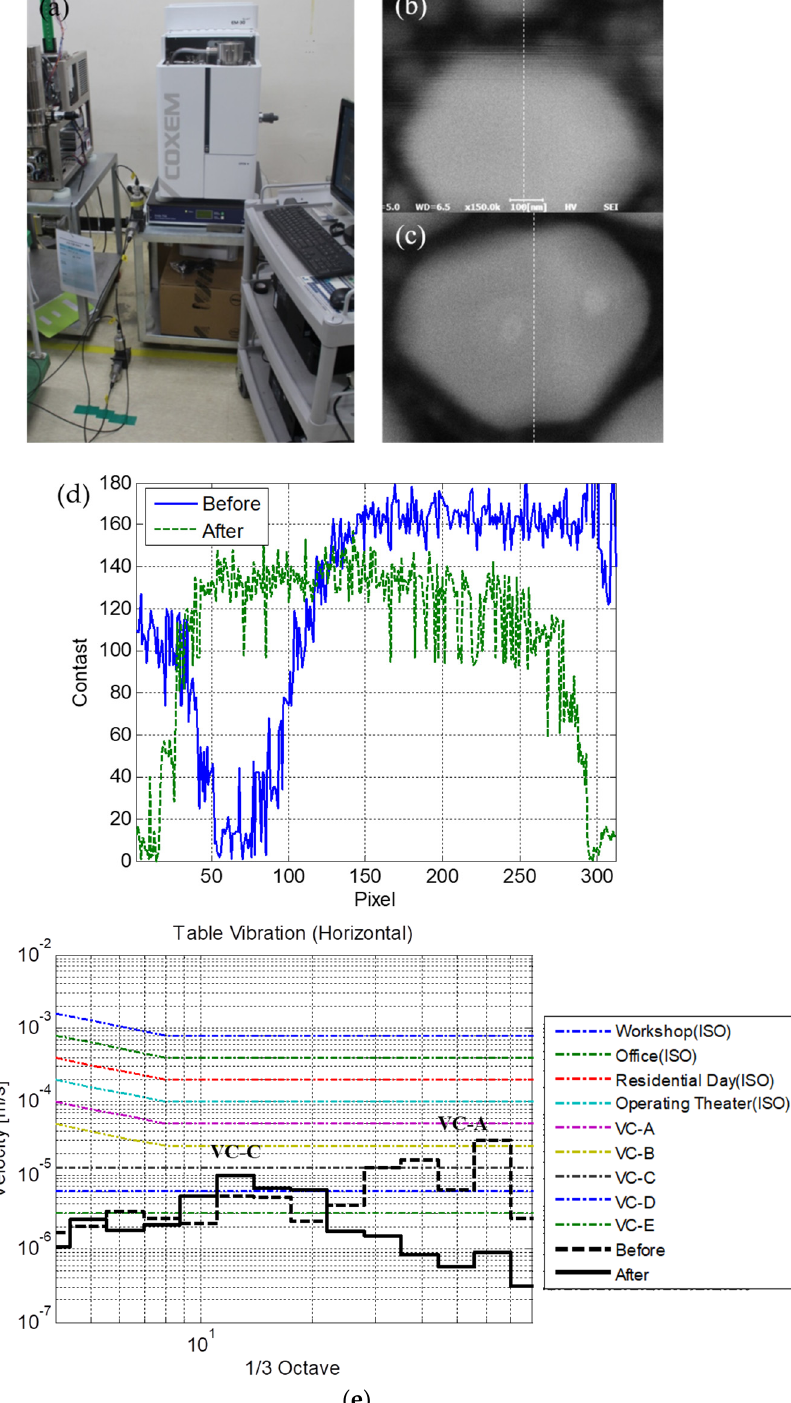
Figure 7. ( a ) Modified configuration of the overall system; measurement results for a specimen obtained using ( b ) wood and ( c ) steel table; ( d ) contrast variations in the specimen pattern images; ( e ) vibration levels compared to the criteria.